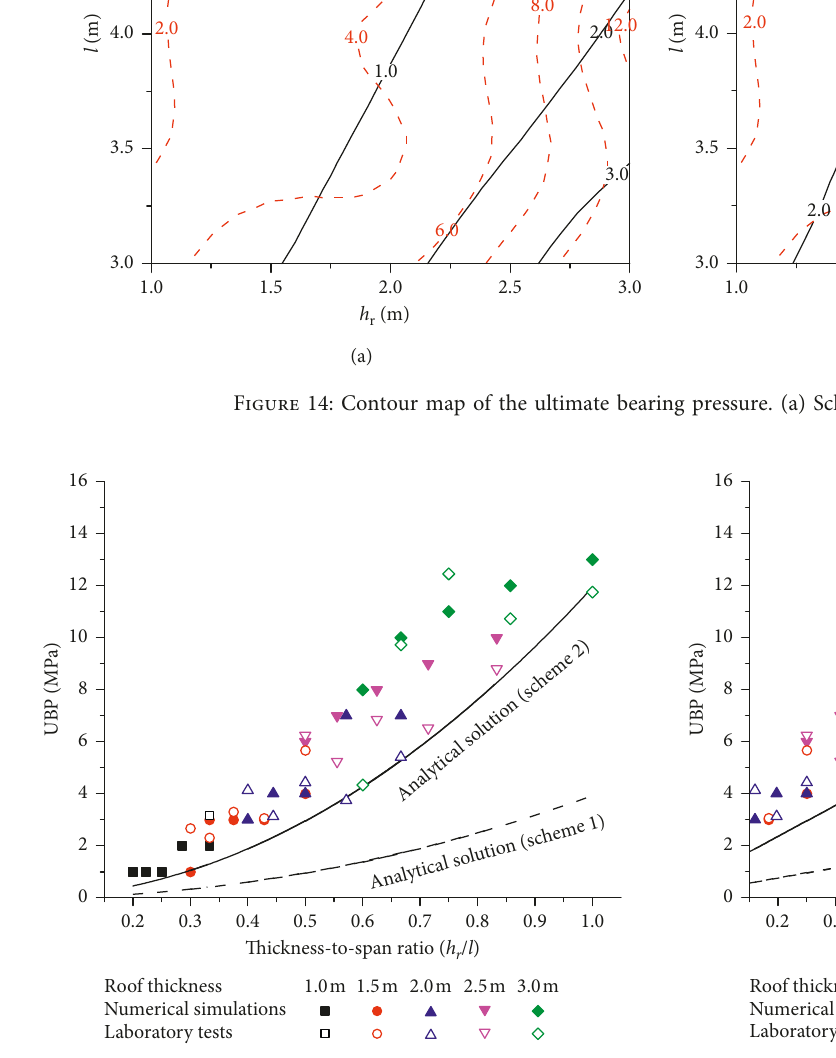
Figure 15: The relationship between the ultimate bearing pressure and the thickness-to-span ratio.